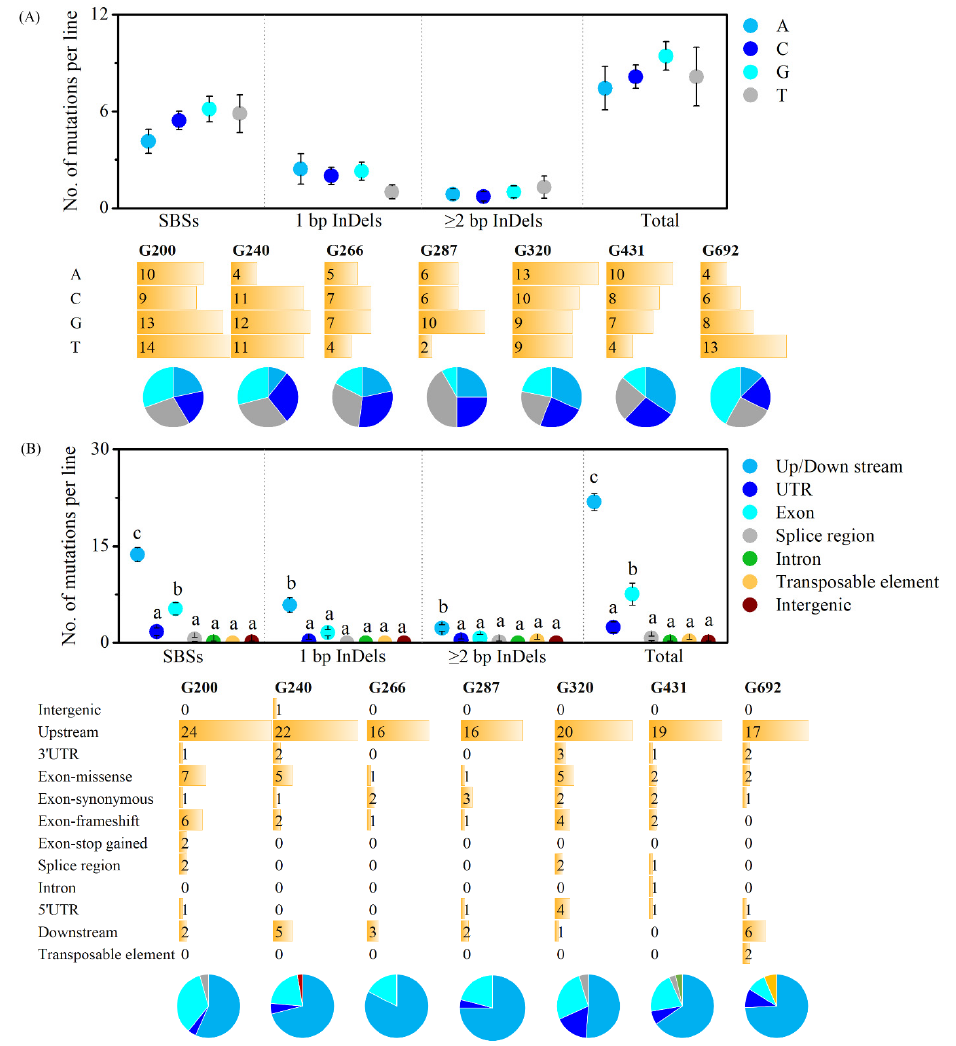
Figure 4. Nucleotide bias of mutations ( A ) and distribution of mutations on gene structure ( B ). Data of scatter plot are mean ± standard error from seven replicates. Data followed by the same alphabetic letters are not significantly different between any two of the mutation types ( p > 0.05) by Duncan’s multiple range test.